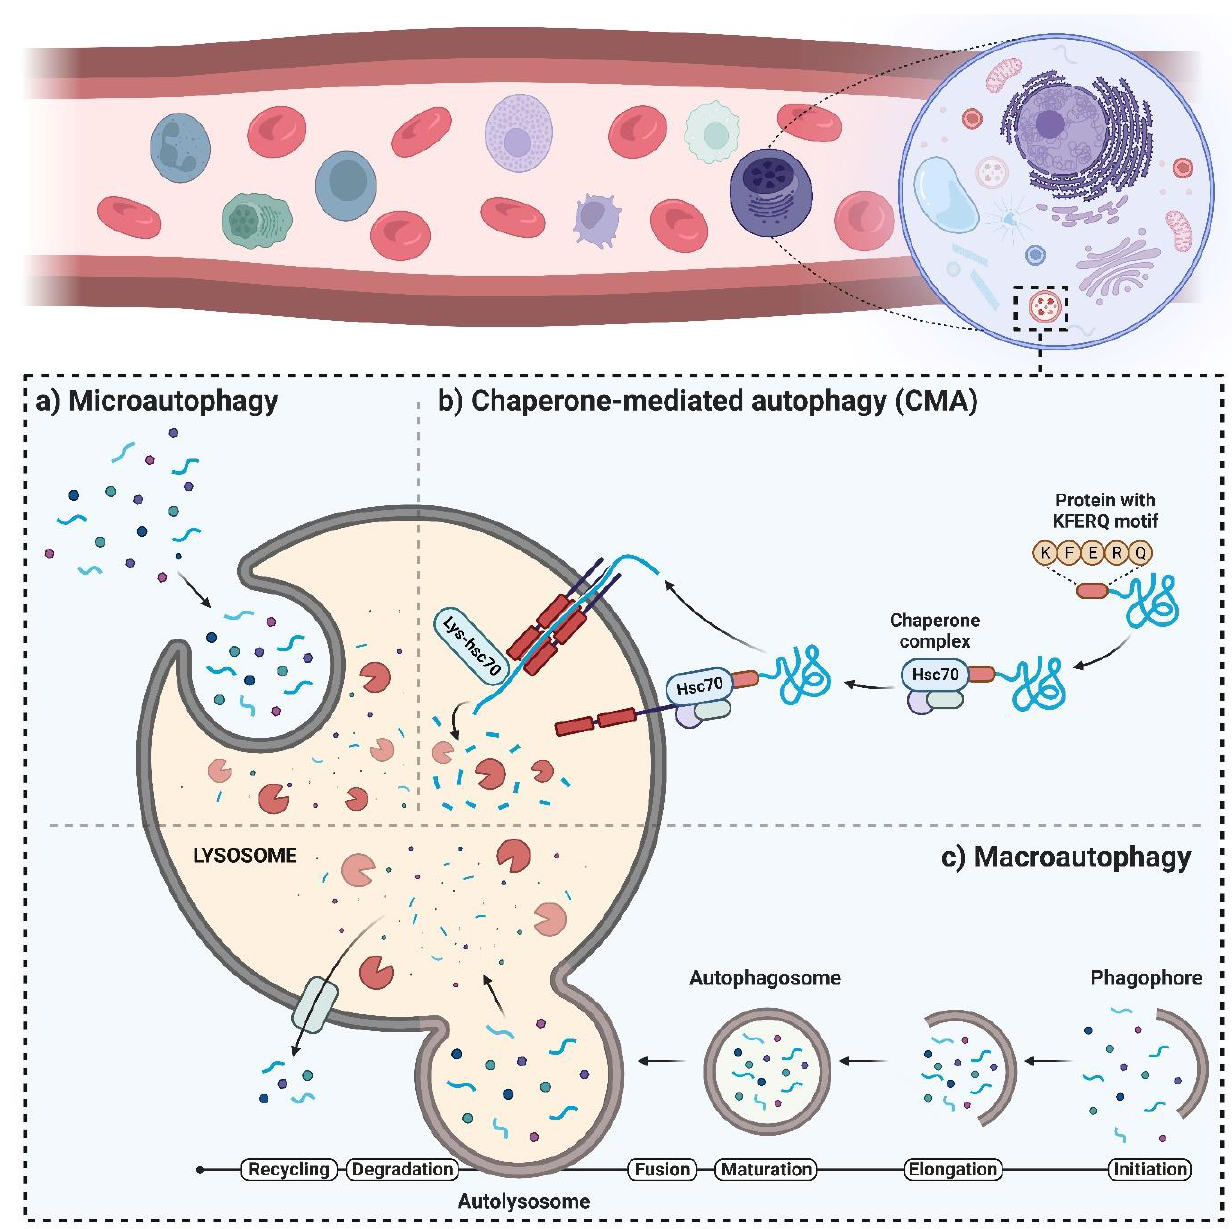
Figure 1. Different types of autophagy: ( a ) microautophagy, ( b ) chaperone-mediated autophagy (CMA), and ( c ) macroautophagy.